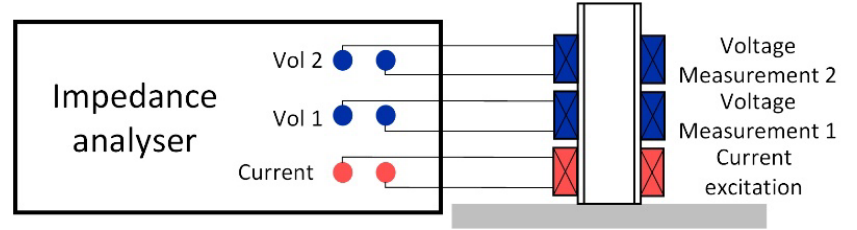
Figure 15. Measurement configuration for lift-off compensation employing triple-coil probe.